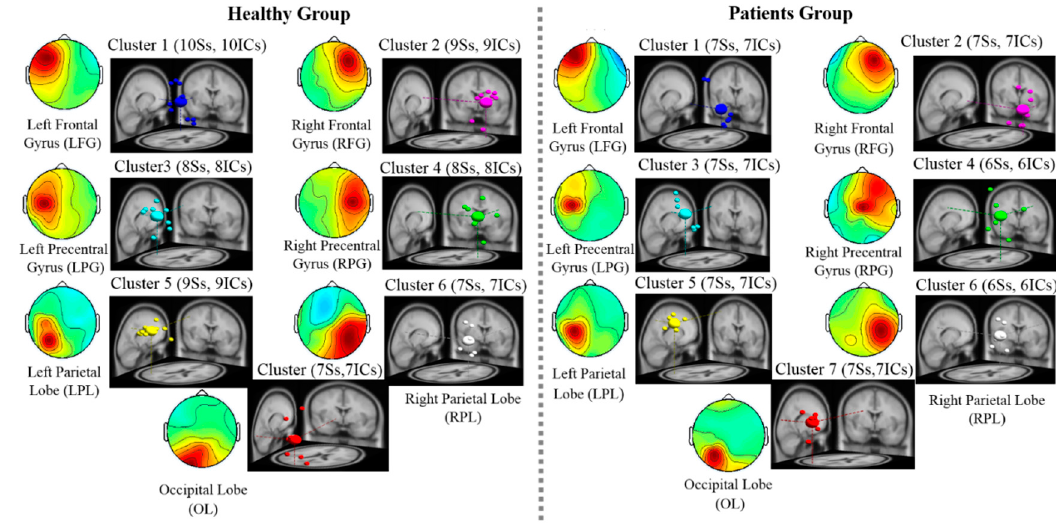
Figure 3. Independent component clusters of dipole locations for the analysis of brain dynamics. The activated seven clusters in healthy subjects and patients with bilateral vestibular hypofunction (BVH) were identified including left frontal gyrus (LFG), right frontal gyrus (RFG), left precentral gyrus (LPG), right precentral gyrus (RPG), left parietal lobe (LPL), right parietal lobe (RPL) and occipital lobe (OL).